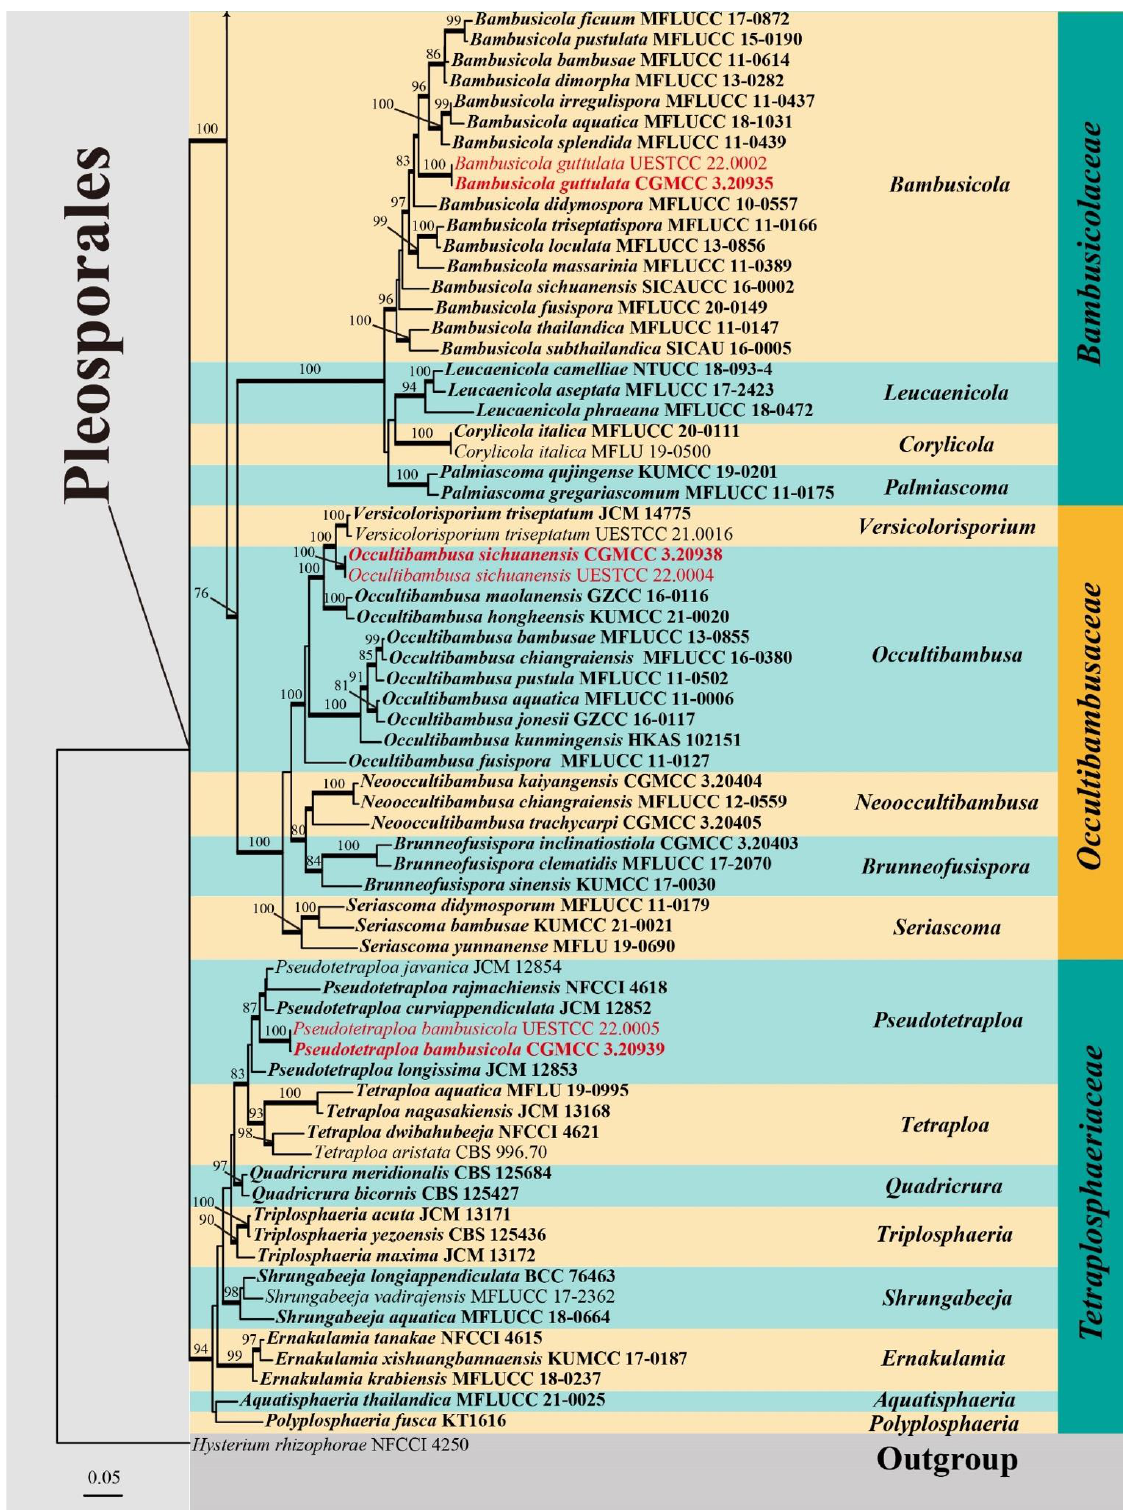
Figure 1. RAxML tree generated from combined SSU, ITS, LSU, RPB2 and TEF1 α sequence data of targeted five families (Amorosiaceae, Bambusicolaceae, Lophiostomataceae,